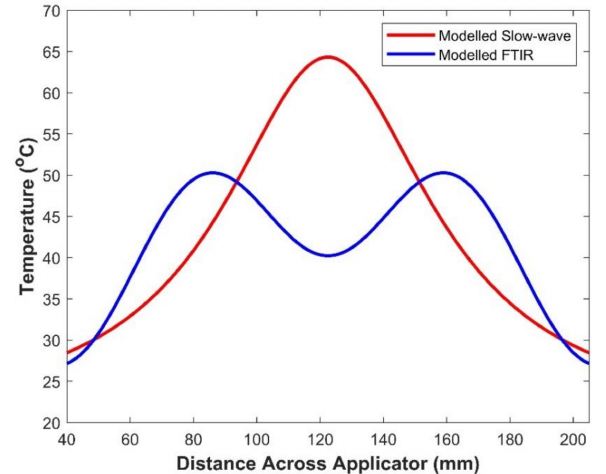
Figure 9. Comparison of the transverse heating profile of the comb slow-wave and FTIR applicator at 30 mm from the start of the applicator and 10 mm depth in the